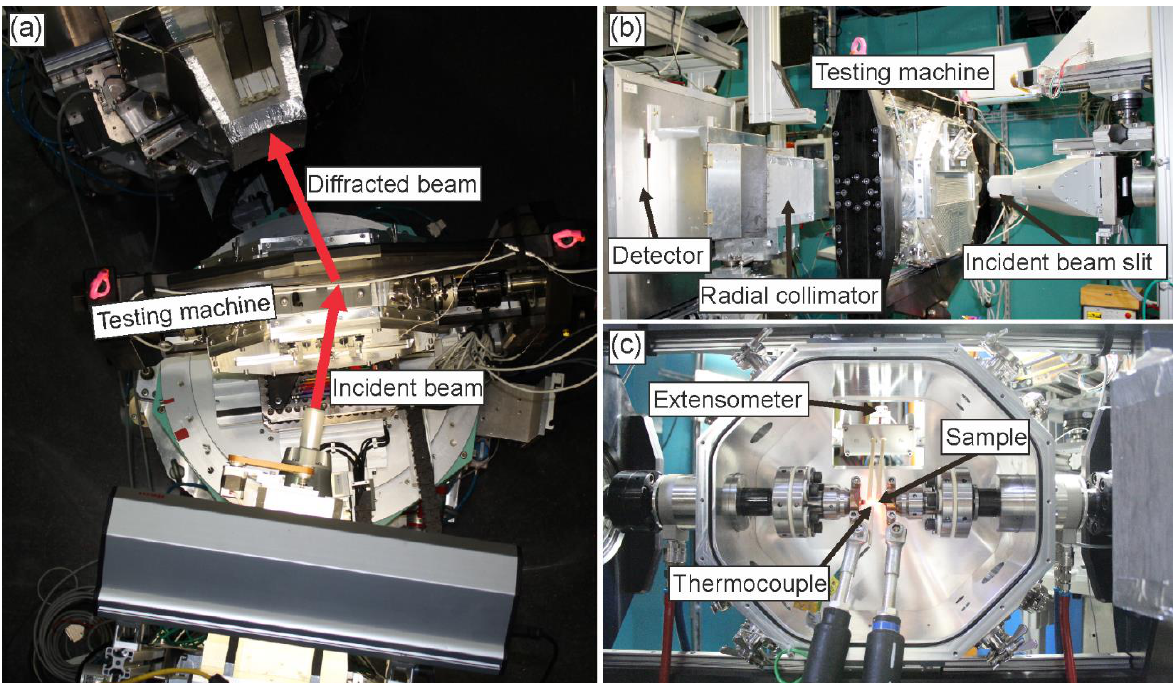
Figure 2. Overview of the experimental setup at the STRESS-SPEC instrument in ( a ) top, ( b ) side-view and ( c ) detail view into the heating chamber of the testing machine.